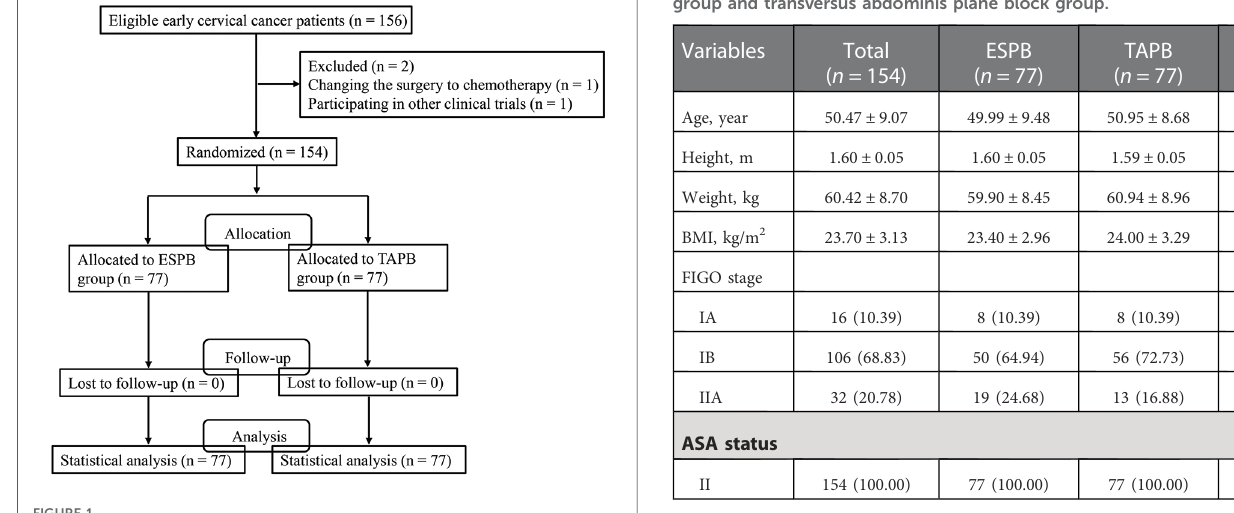
FIGURE 1 The fl owchart of patient selection.